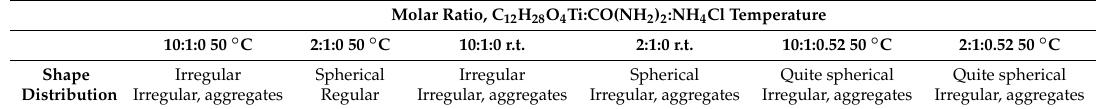
Table 7. Morphological characteristic of TiO 2 NPs.